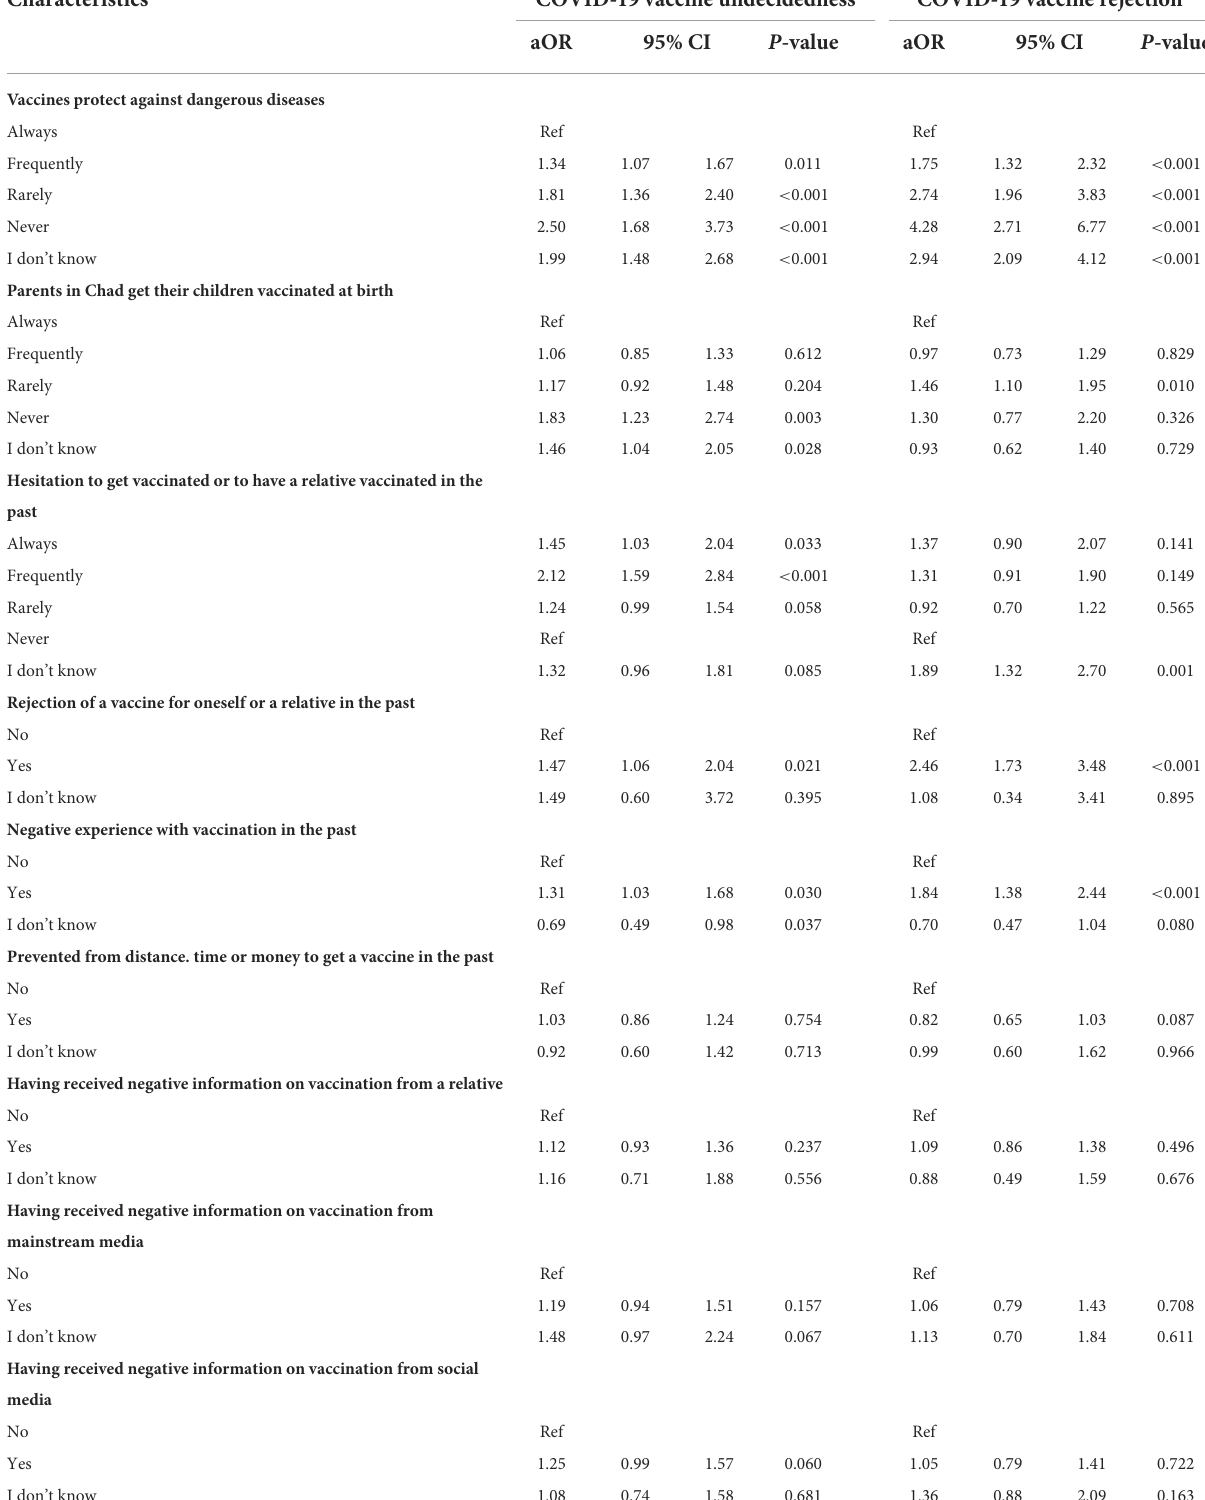
TABLE 6 Beliefs and attitudes predictors of COVID-19 vaccine undecidedness or rejection: multivariate analysis.